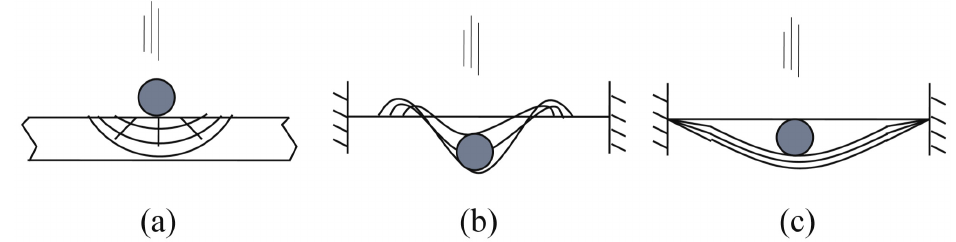
Figure 11. Various categories of impacts ( a ) Very short impact time ( b ) Short impact time ( c ) Long impact time [78].